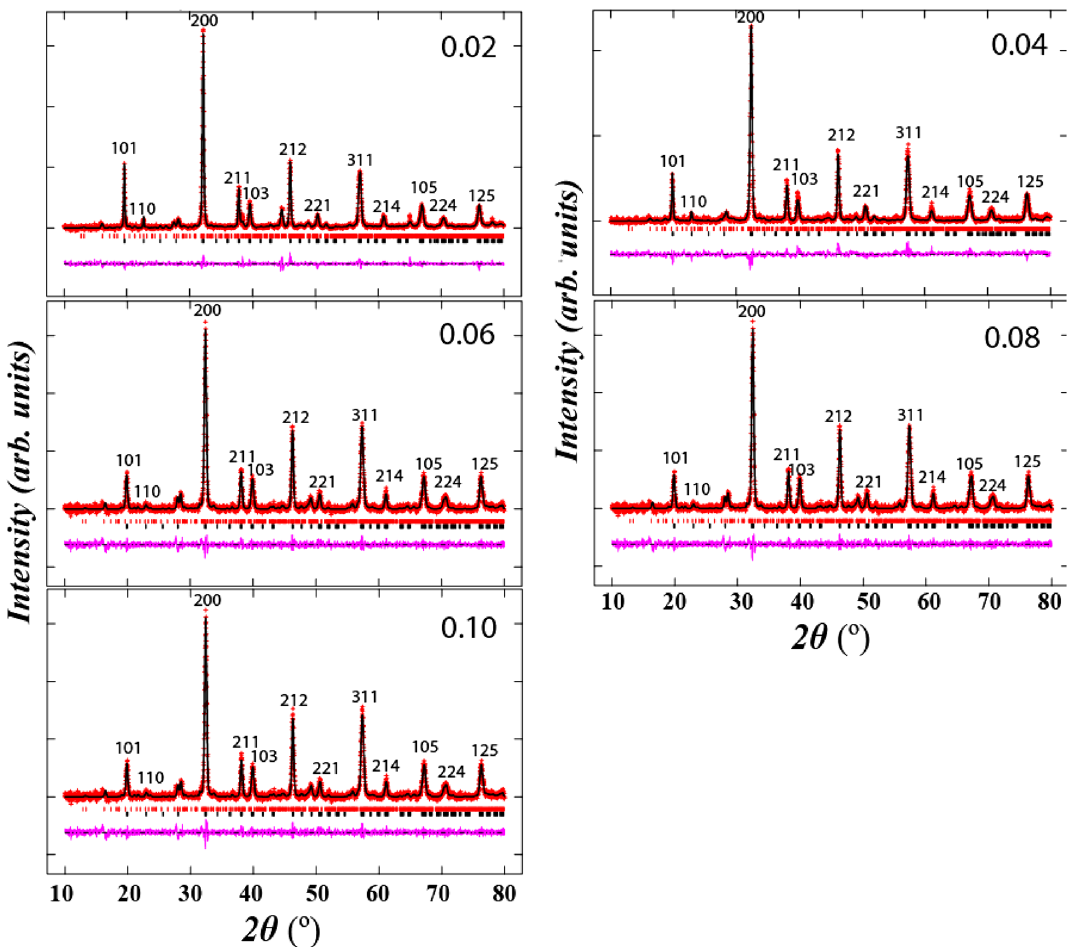
Figure 1. Refinement of XRD pattern of SrLaLiTe 1− x Mn x O 6 . The black lines, red lines and pink lines are the calculated pattern, the observed data, and the difference, respectively. Black and red ticks are the Bragg reflections for primary and secondary phases,